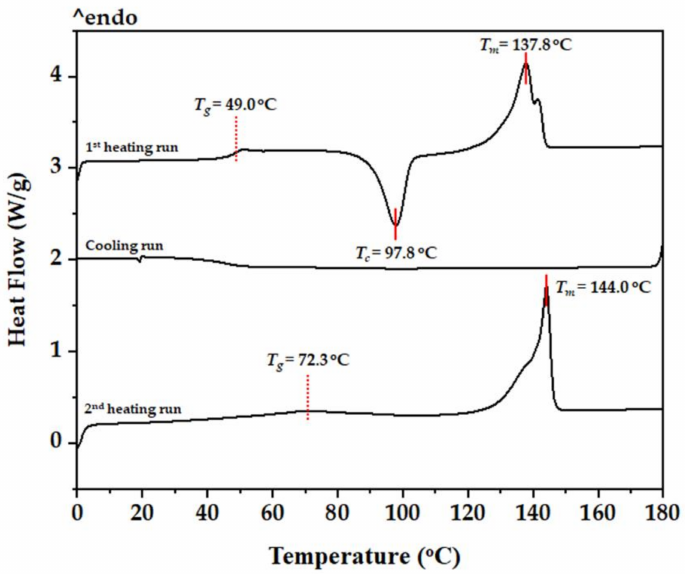
Figure 7. Representative DSC heating/cooling/heating thermograms of the P(MLA20- g -LLA) 1:30 showing its T g , T c , and T m .